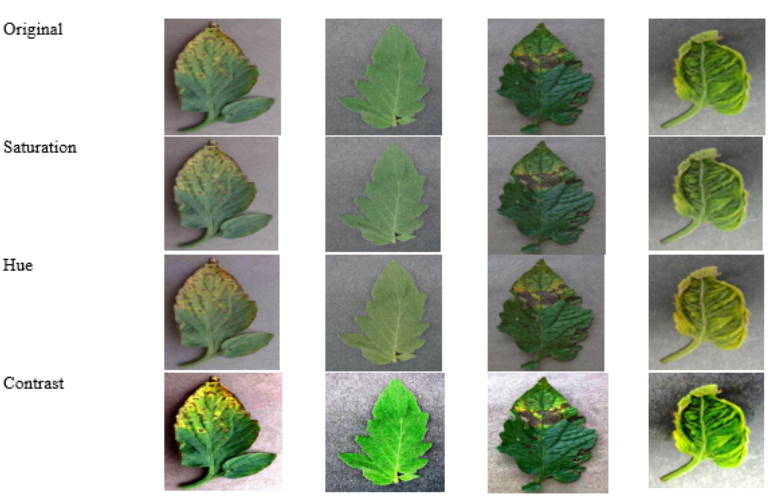
Figure 5. Pre-processed samples of a dataset of